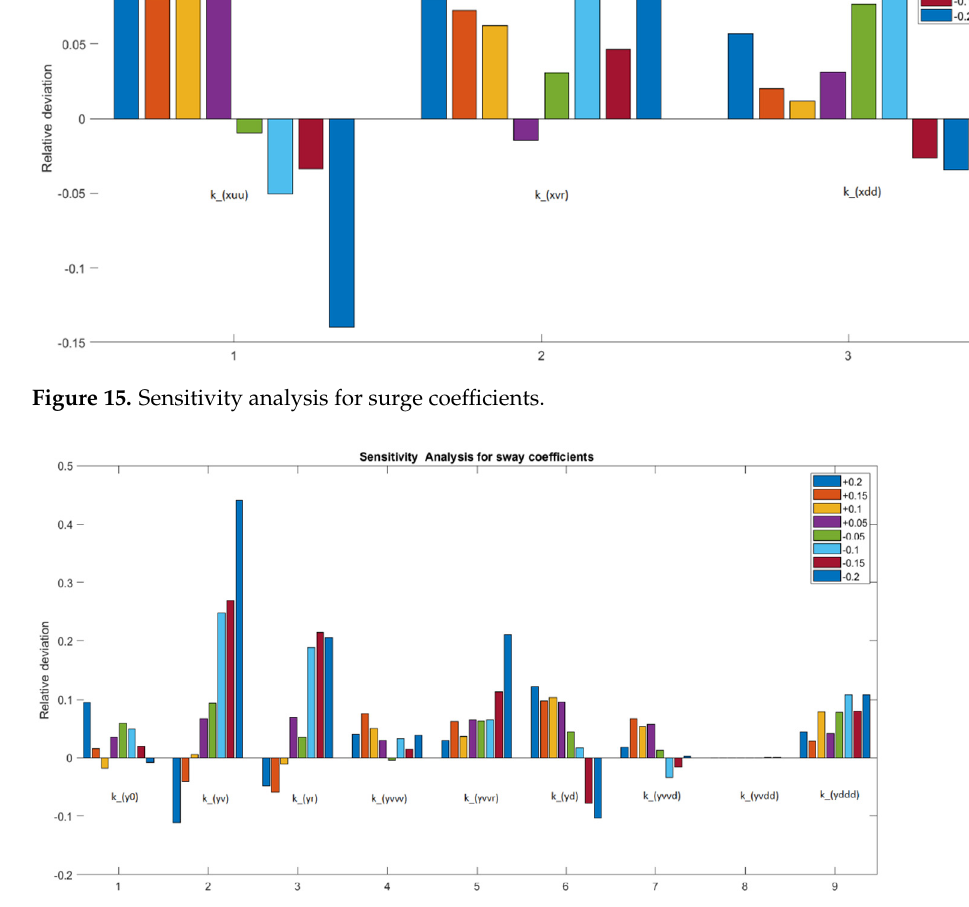
Figure 17. Sensitivity analysis for yaw coefficients. Finally, regarding the yaw coefficients, the linear and the rudder coefficients 𝑘 (cid:3041)(cid:3049) , 𝑘 (cid:3041)(cid:3045) , and 𝑘 (cid:3041)(cid:3031) were the most important ones. The relative deviations were much larger consid- ering the yaw coefficients than in the previous two motions. In the previous motions, the maximum sensitivity was below 15% for surge and 50% for sway. However, in the yaw motion, there was one variation that went beyond 100%, and others that were between 50% and 100%. Additionally, it had more coefficients with less influence when compared with sway. The coefficients 𝑘 (cid:3041)(cid:2868) , 𝑘 (cid:3041)(cid:3049)(cid:3049)(cid:3049) , 𝑘 (cid:3041)(cid:3049)(cid:3049)(cid:3031) , 𝑘 (cid:3041)(cid:3049)(cid:3031)(cid:3031) , and 𝑘 (cid:3041)(cid:3031)(cid:3031)(cid:3031) had smaller relative devia- tions regarding the yaw coefficients, even if they were in the range of the higher ones in the surge and sway motions. Interestingly, regarding the motion, almost no coefficient behaved in the same way regarding the variation from unitary values. Only 𝑘 (cid:3052)(cid:3083)(cid:3083)(cid:3083) had a consistent positive relative deviation with all eight variations. Additionally, the sensitivity analysis also corroborated the identification and validation of the coefficients. This once again proves that not all the coefficients are necessary to predict a manoeuvre and that can be used as an aid to the least squares method combined with the truncated singular value decomposition to have a better final response to the best estimate of the adjustment coefficients. 6. Conclusions In this study, an estimation of the adjustment coefficients was performed using a least squares method combined with the truncated singular value decomposition. The addition